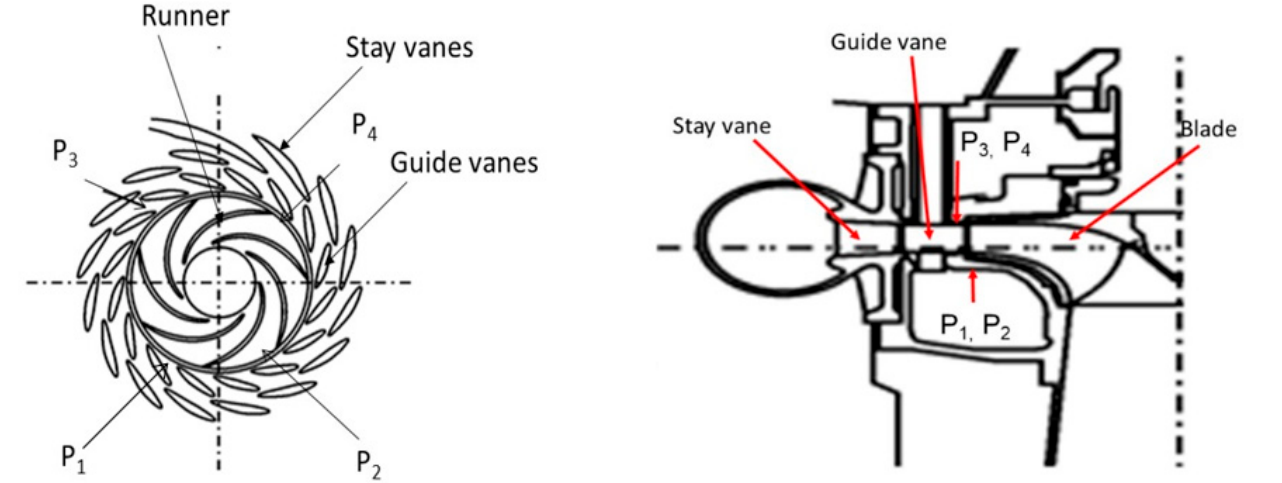
measured by the transducers, plotted vs. normalized time (cid:1872) ∗ (using the time of one revo- lution of the runner as a reference value). Figure 6. Location of the pressure transducers installed for the experimental study [24]. Wika S-10 pressure transducers were used for the experimental measurements [25].